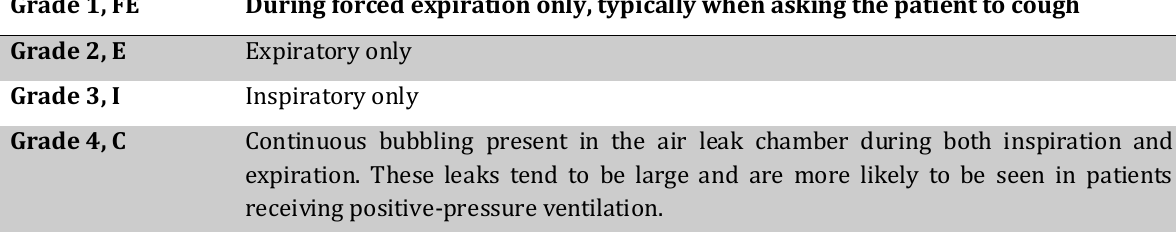
Table 1: Cerfolio Classification of Air Leaks Grade 1, FE